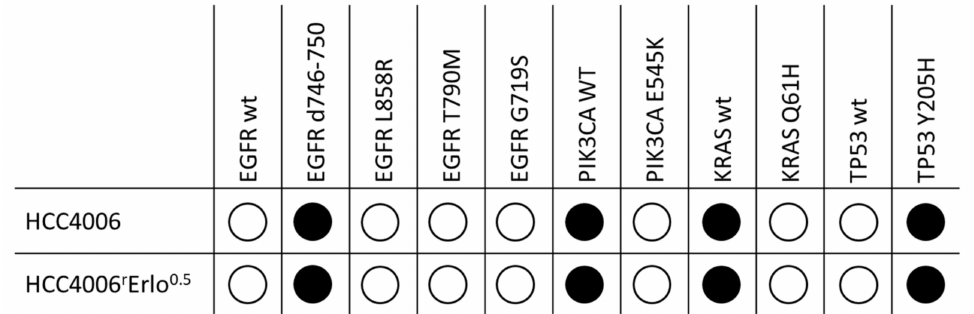
Figure 1. Genetic characteristics of native HCC4006 and HCC4006 r Erlo 0.5 cells adapted to grow in the presence of 0.5 µ M erlotinib. DNA was isolated, and a DNA library of fifteen common tumor genes was prepared using the TrusightTumor15 panel and analyzed on a MiniSeq System using Illumina BaseSpace Variant Interpreter and BaseSpace Annotation Engine 1.6.2.0 (Illumina, Inc., San Diego, CA, USA). Black bullets denote the identified genetic variant of the respective